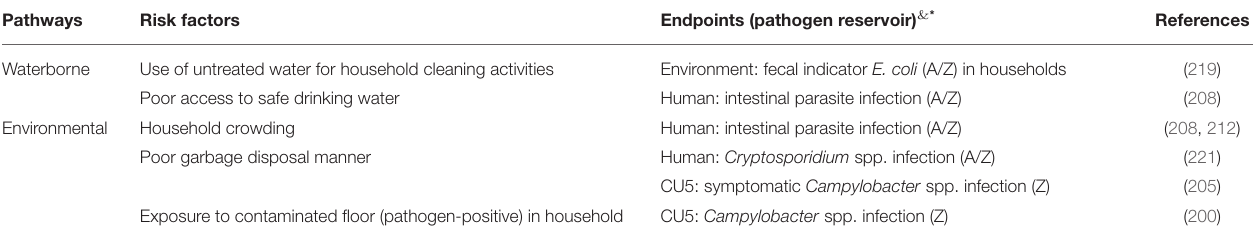
TABLE 3 | Risk factors associated with the presence of zoonotic enteric pathogens in different endpoints (livestock, environment, human at all age range, and children under-five) through the animal contact pathway in smallholders in low- and middle- income countries (LMIC). Pathway